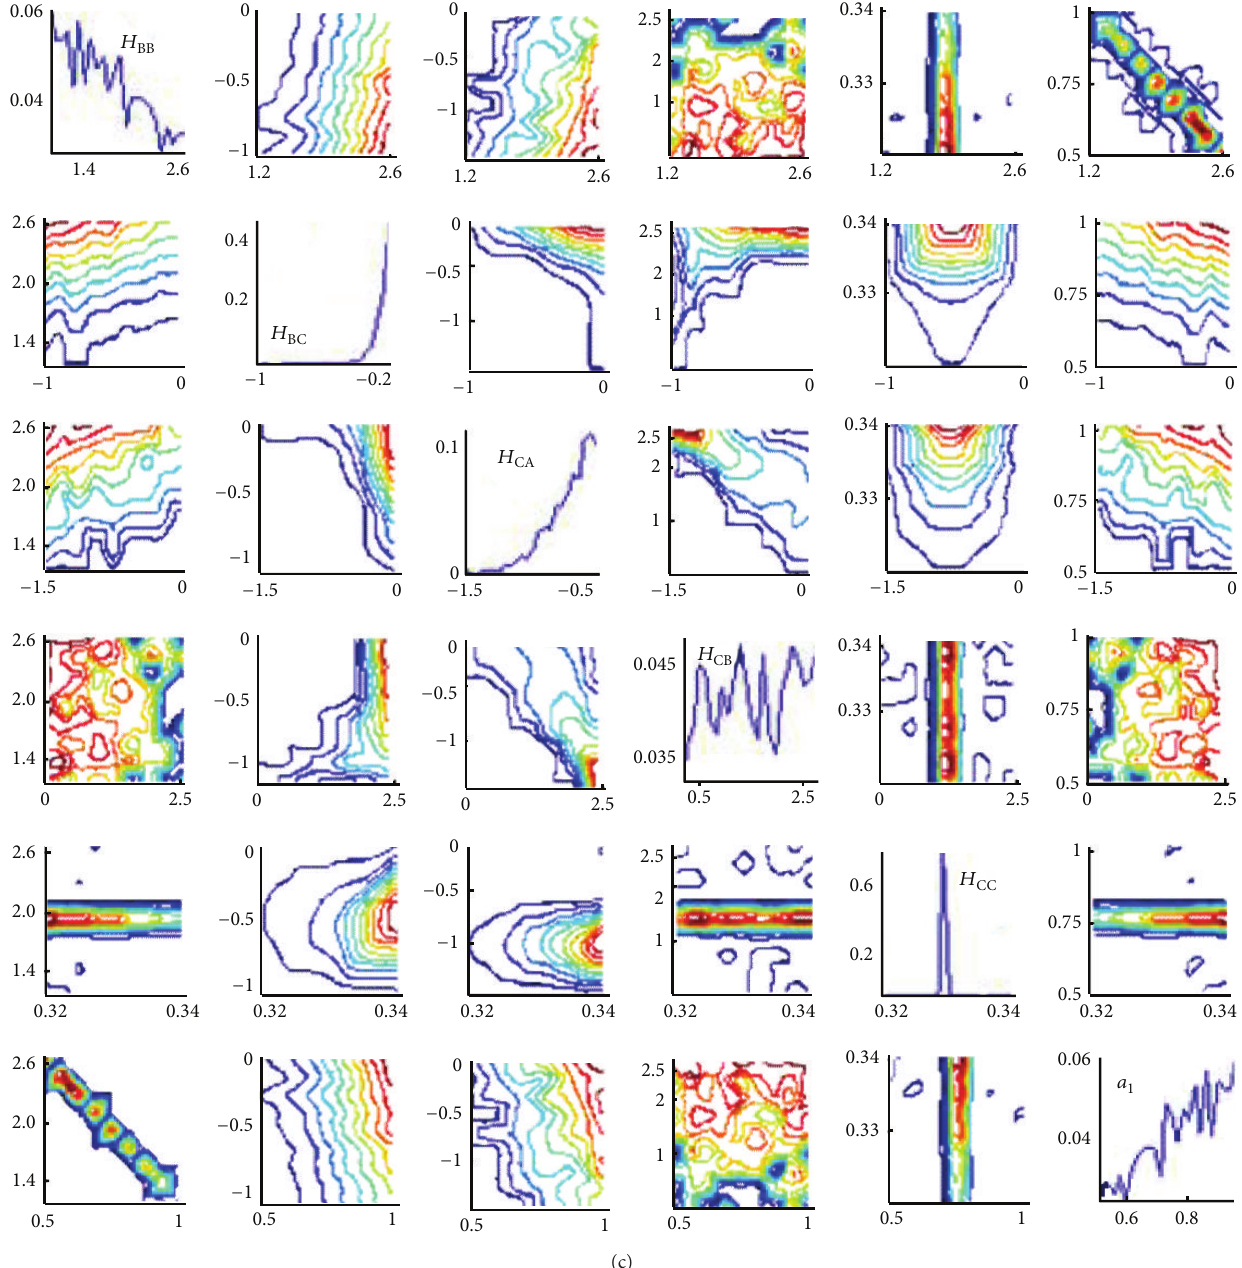
Figure 5: (a) In the yeast nitrogen catabolite repression system, the transcription factor Gat1p is activated in response to Gln3p. It can then activate its own transcription, as well as Dal80p, which binds to the same sequences as Gat1p and represses transcription. (b) Principal component analysis of the posterior distribution for model 6. PC1 is the first principal component, while PC8 describes the direction of least variance and therefore the most sensitive parameters. 𝑎 0 , 𝑎 1 , and 𝑎 2 are the degradation constants for components A, B, and C, respectively. 𝜆 indicates the eigenvalue of variance covariance matrix. (c) Parameter posterior distribution for Model 6. 𝑎 time scale for